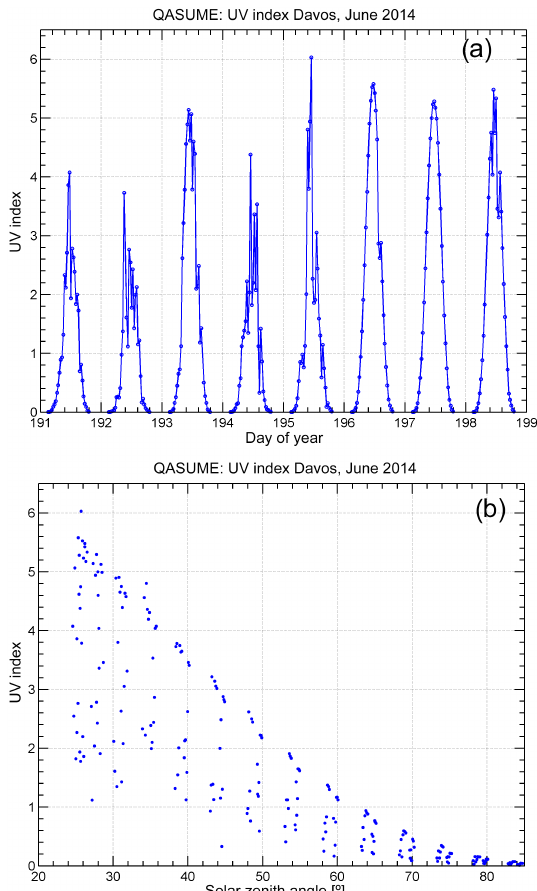
Figure 2. (a) Measurements of the UV index during 10 to 17 July (day of year 191–198) obtained by the reference double monochro- mator QASUME. (b) The UV index from QASUME as a function of the solar zenith angle.